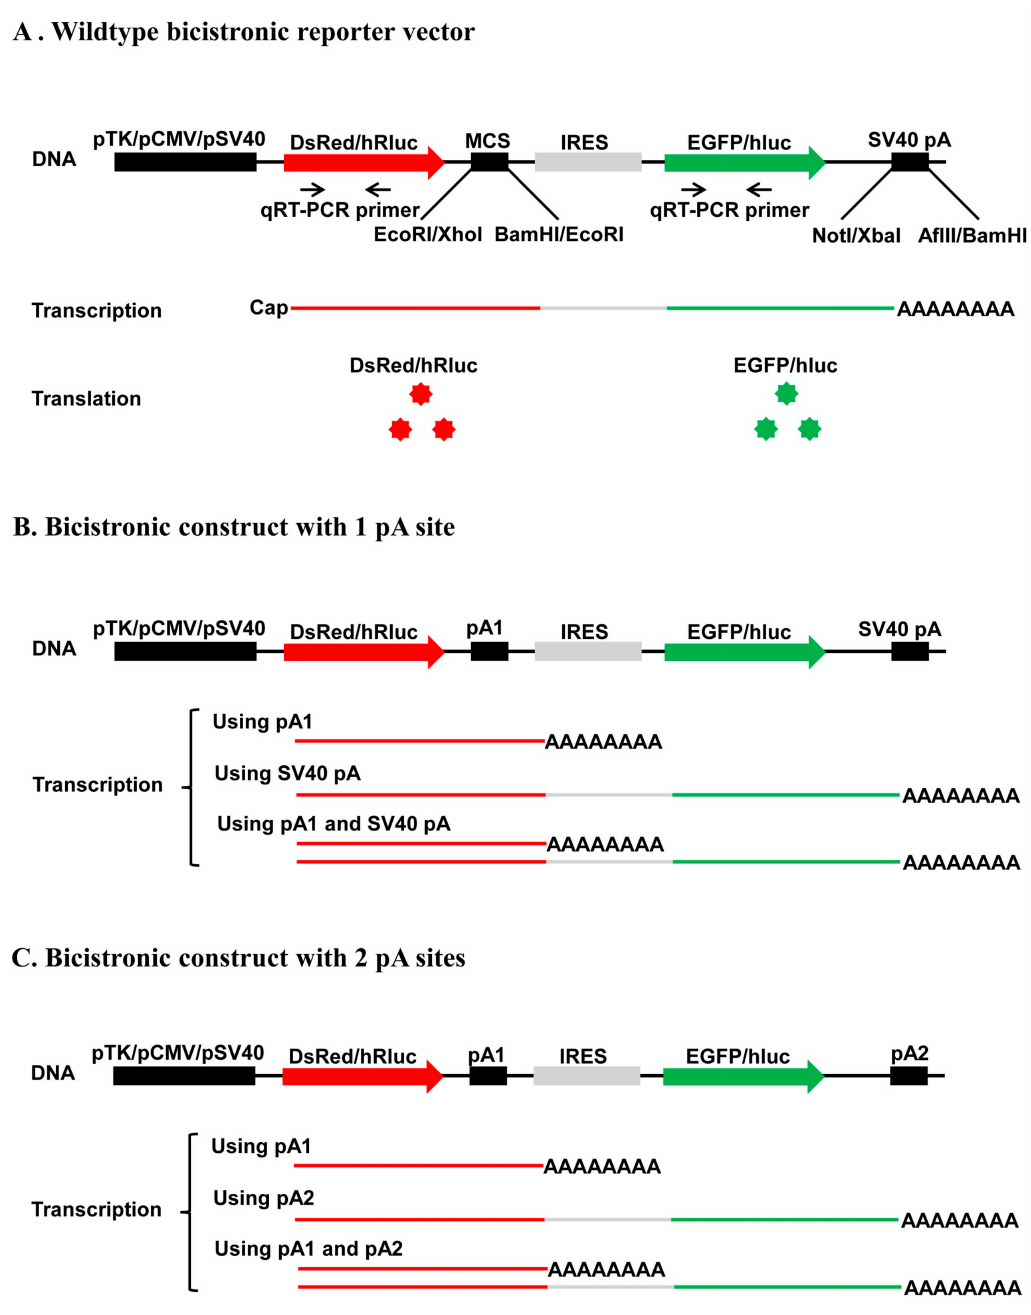
Figure 2. Diagram of the working principle of the bicistronic reporter system. ( A ) Wildtype bicistronic reporter vector is supposed to transcribe into a bicistronic mRNA possessing 1 cap, 2 ORFs (DsRed and EGFP for the 2 fluorescence wildtype vectors and hluc and hRluc for the 2 luciferase wildtype vectors), and 1 pA tail when transfected into mammalian or insect cells. Translation of the 1st (DsRed or hRluc) and 2nd ORFs (EGFP or hluc) is initiated at the normal 5 (cid:48) cap and the IRES, respectively; ( B ) Bicistronic construct with 1 pA site may transcribe into (1) a monocistronic mRNA containing only the 1st ORF; (2) a bicistronic mRNA possessing both ORFs as the wildtype vectors; and (3) both of the above, depending on the polyadenylation capability of the inserted candidate pA site relative to that of the SV40 pA site; ( C ) Bicistronic construct with 2 pA sites may also transcribe into (1) a monocistronic mRNA containing only the 1st ORF; (2) a bicistronic mRNA possessing both ORFs as the wildtype vectors; and (3) both of the above, depending on the relative polyadenylation efficiency of the two inserted candidate pA